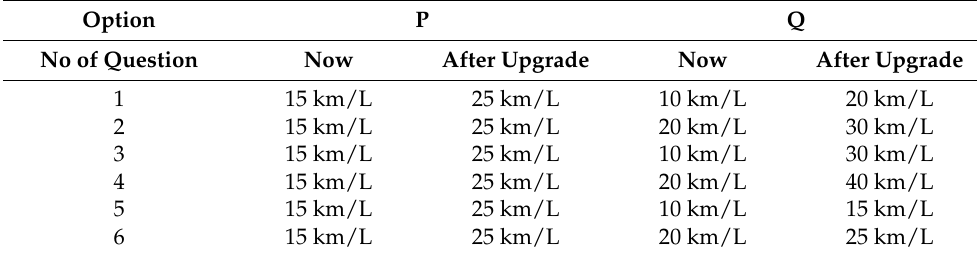
Table 1. Questions to measure the MPG (KPL)